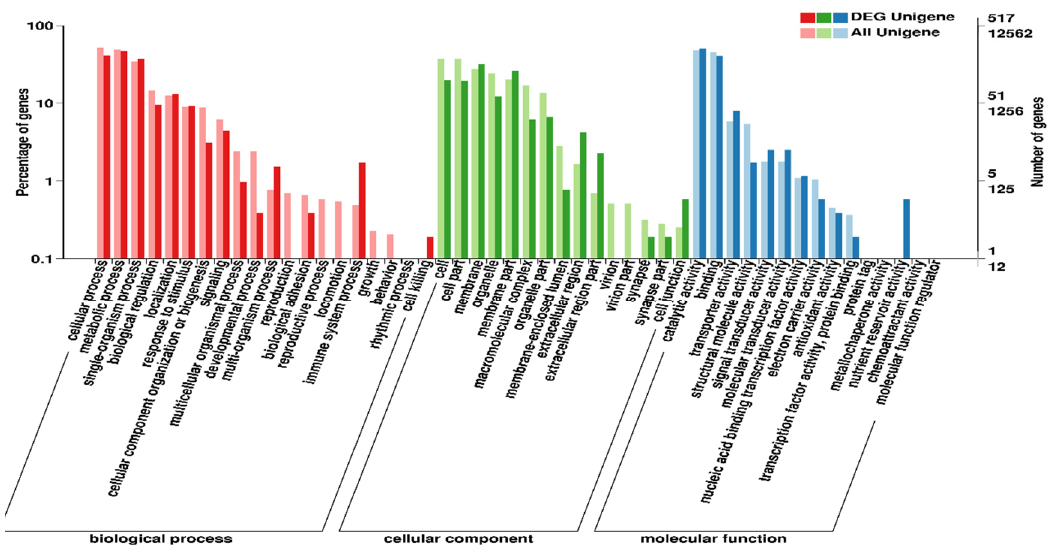
Figure 3. The top 25 GO terms in biological process cellular components, and molecular function categories with enriched in the differentially expressed gene. The Y-axis corresponds to the number of DEGs, whereas the X-axis shows different gene functions.